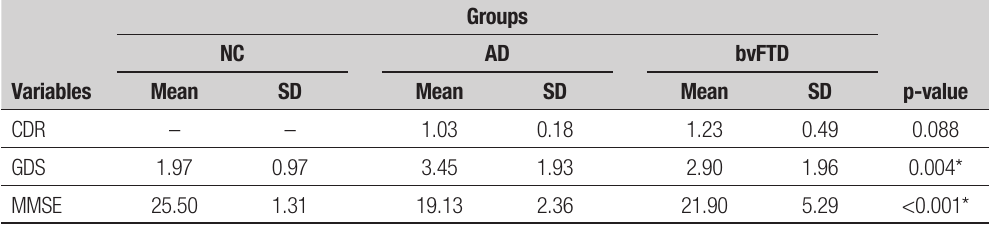
Table 2. Clinical characteristics of the sample.